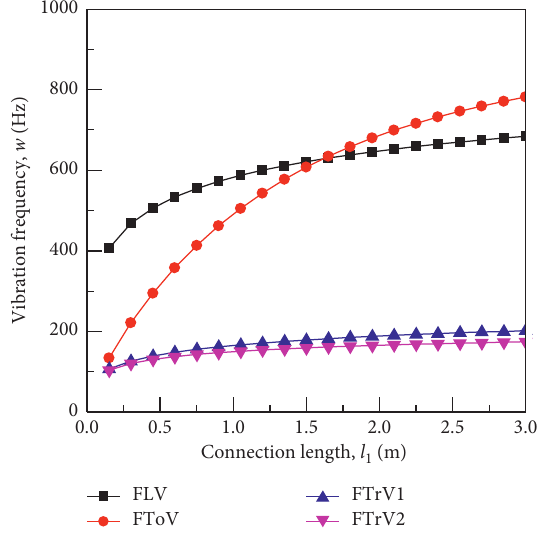
Figure 3: Variation of the natural frequency of the rocks.